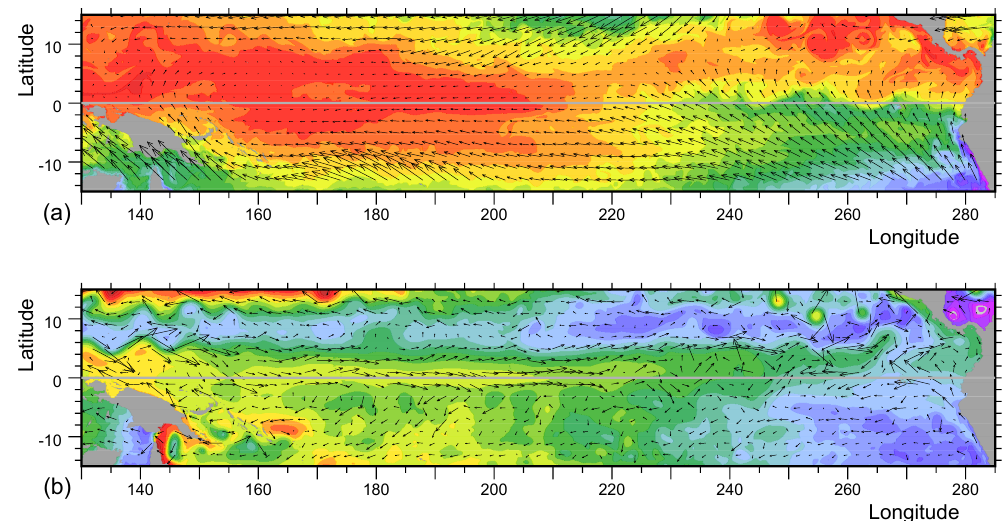
Figure 34. (a) Surface temperature and wind stress vectors. (b) SSH and velocity vectors are from the 29 June 1997 archive dataset. Colours and vector scales are as in Fig.